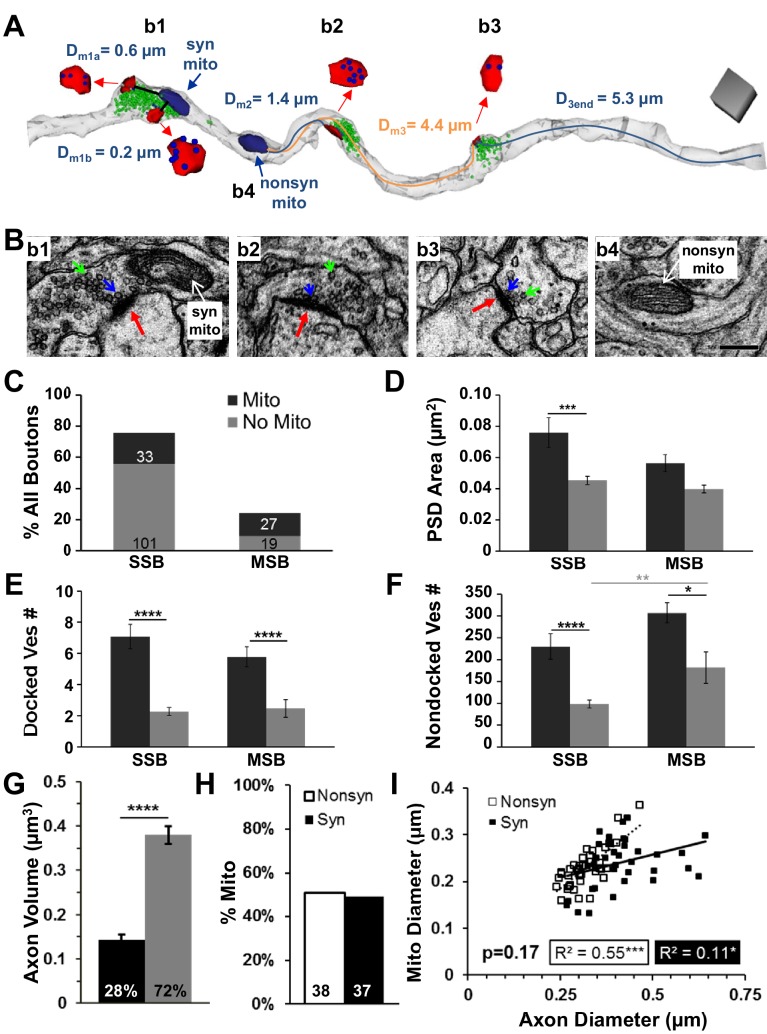
Presynaptic boutons with mitochondria had more vesicles than those without mitochondria in PF hippocampal area CA1 at P15.(A) Three neighboring presynaptic boutons located along the same axon (translucent gray). Bouton 1 (b1) was an MSB with two postsynaptic partners (PSDs, red) that contained a mitochondrion (navy), 303 nondocked vesicles (green), and 12 docked vesicles (blue, inset). Nearest distances from each PSD to the mitochondrion were less than 1 µm (Dm1a, 1b). For b2, the distance from the edge of the PSD to the nearest mitochondrion was 1.4 µm (Dm2, blue line), and it contained 124 nondocked vesicles and nine docked vesicles. The b3 had 82 nondocked vesicles and two vesicles docked at the PSD which was 4.4 µm from the nearest mitochondrion (b4, nonsyn mito, Dm3, orange line) and 5.3 µm from the end of the axon reconstruction (D3end). Scale cube is 0.5 µm on each side. (B) Representative EMs from four regions along an axon illustrating boutons with PSDs (red arrows), nondocked vesicles (green arrows), and docked vesicles (blue arrows) and a nonsynaptic inter-bouton region containing a mitochondrion (nonsyn mito). Scale bar is 0.25 µm in b4 for all four micrographs. (C) Of all the axonal boutons, 76% were SSBs and 24% were MSBs. Absolute numbers of boutons are in corresponding bars that also indicate the presence (black) or absence of a mitochondrion (gray). (D) Overall, the PSD areas did not differ between synapses on MSBs and SSBs (n = 216, F1,215 = 0.026, p=0.87). However, PSD areas were larger on SSBs when mitochondria were present (n = 140, F1,138 = 15.4, p<0.001), but on MSBs this difference did not reach significance (n = 75, F1,74 = 2.791, p=0.10). (E) The number of docked vesicles per PSD did not differ between MSBs and SSBs with or without mitochondria (n = 177, F1,175 = 0.26, p=0.61); however, the number of docked vesicles per PSD was greater for both types of boutons with mitochondria than those without mitochondria (n = 177, F1,175 = 65.1, p<0.001). (F) Boutons with mitochondria had more nondocked vesicles whether they were SSBs or MSBs (n = 180, F1,178 = 16.2). Since the pool of nondocked vesicles could not be attributed to a specific PSD, the MSBs had more nondocked vesicles than SSBs, which reached significance for those boutons without mitochondria (gray line above the bars). (G) Axon segments containing mitochondria somewhere along their lengths were analyzed and the amount of axon volume with mitochondria was significantly less than the amount of axon volume without mitochondria (n = 81, ANOVA, F1,161 = 104.1, p<0.0001). (H) Of all axonal mitochondria in the perfusion fixed condition from the brick analyses (see Figure 2E), 51% of mitochondria resided in nonsynaptic regions (Nonsyn), while 49% resided in synaptic boutons (Syn). (I) Axonal and mitochondrial diameters were correlated and this relationship did not differ significantly between mitochondria located in synaptic or nonsynaptic regions of the axons from (H) (n = 75, ANCOVA, F1,72 = 1.91, p=0.17). Significant post hoc differences are indicated as *p<0.05, **p<0.01, ***p<0.001, and ****p<0.0001.